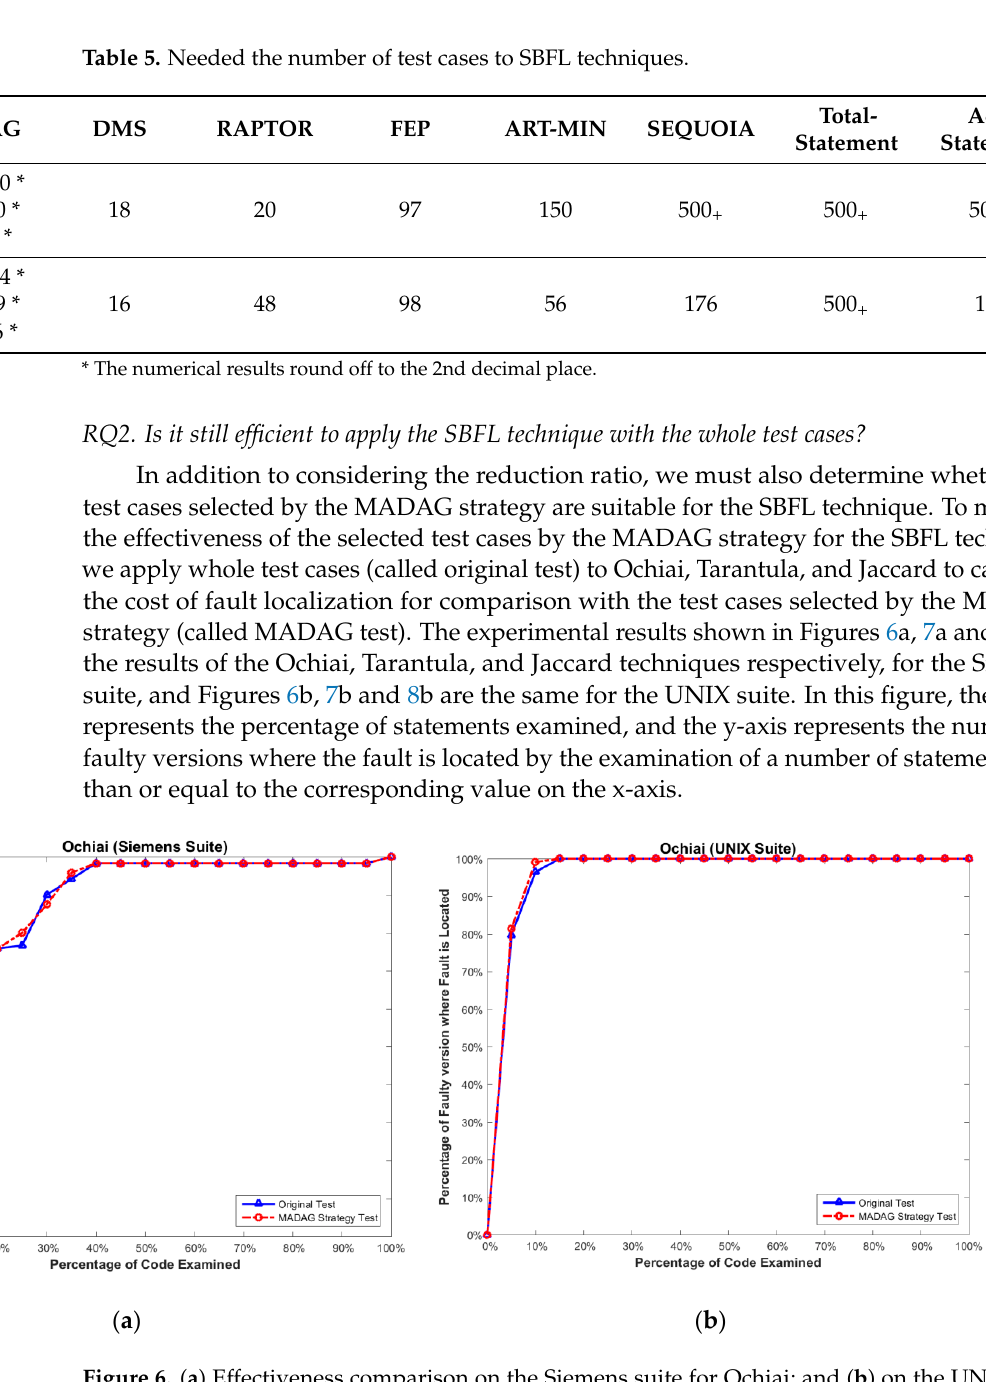
( b ) Figure 7. ( a ) Effectiveness comparison on the Siemens suite for Tarantula ; and ( b ) on the UNIX suite for Tarantula .